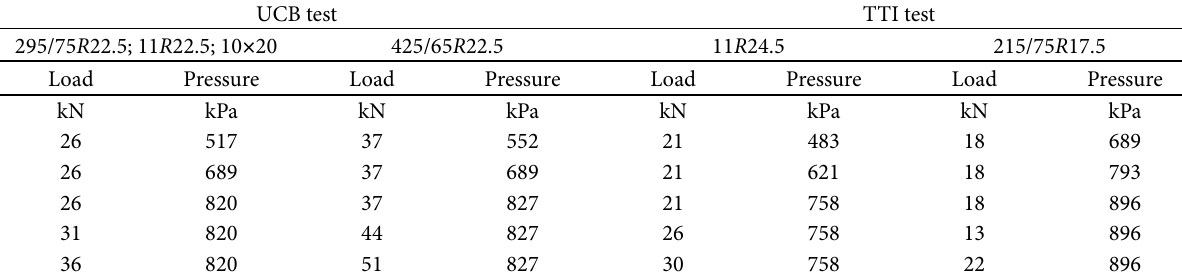
Table 1. Summary of load and tire inflation pressure combinations used in analyses UCB test TTI